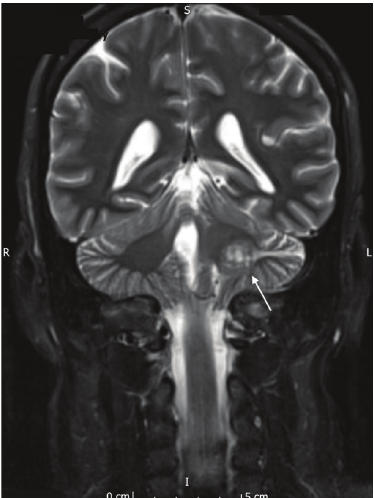
Figure 3: Coronal MR image (T2 weighted, fat saturated) showing the vestibular schwannoma affecting the left vestibulocochlear nerve.